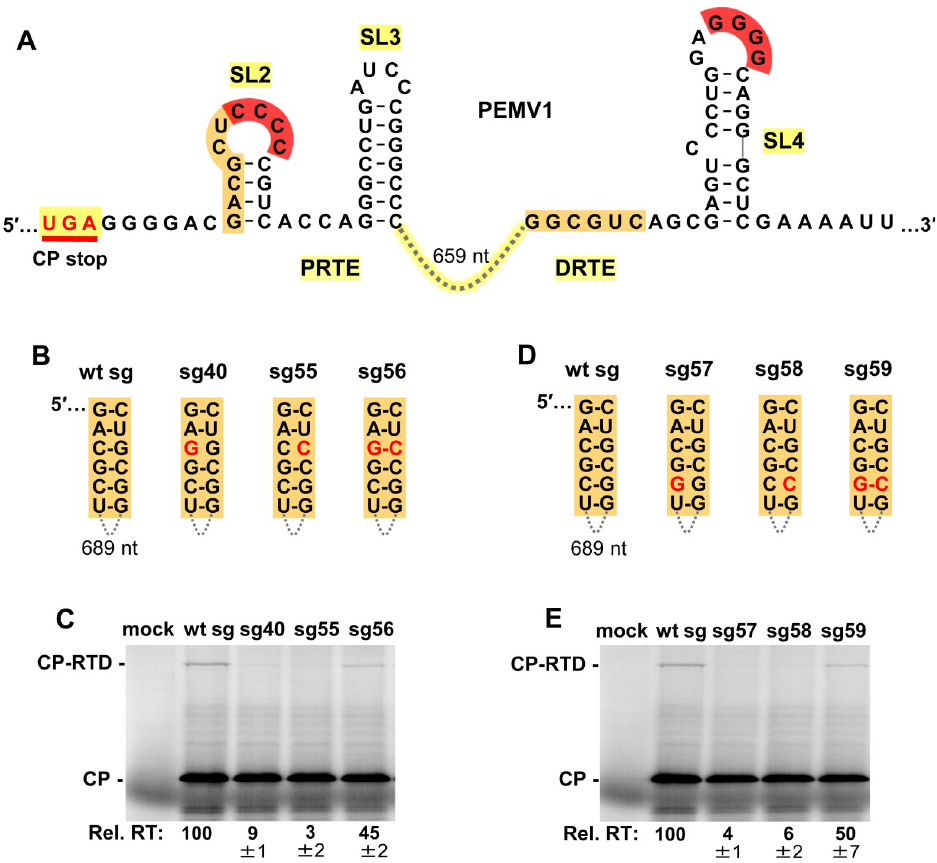
Fig 4. Assessing the orange long-distance RNA-RNA interaction. (A) RNA secondary structures of PRTE and DRTE in PEMV1. (B) and (D) Compensatory mutations introduced in the sg mRNA to test the orange interaction. Nucleotide substitutions are shown in red. (C) and (E) In vitro translation analyses of the wt and mutant sg mRNAs shown in panels B and D, respectively. Averaged Rel. RT levels ( ± SE) collected from three independent trials are shown below each